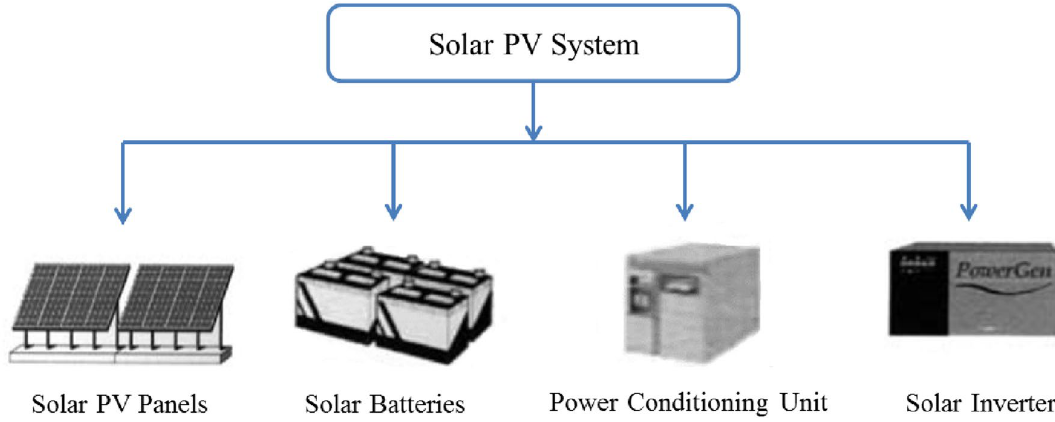
Figure 1. Solar PV components.